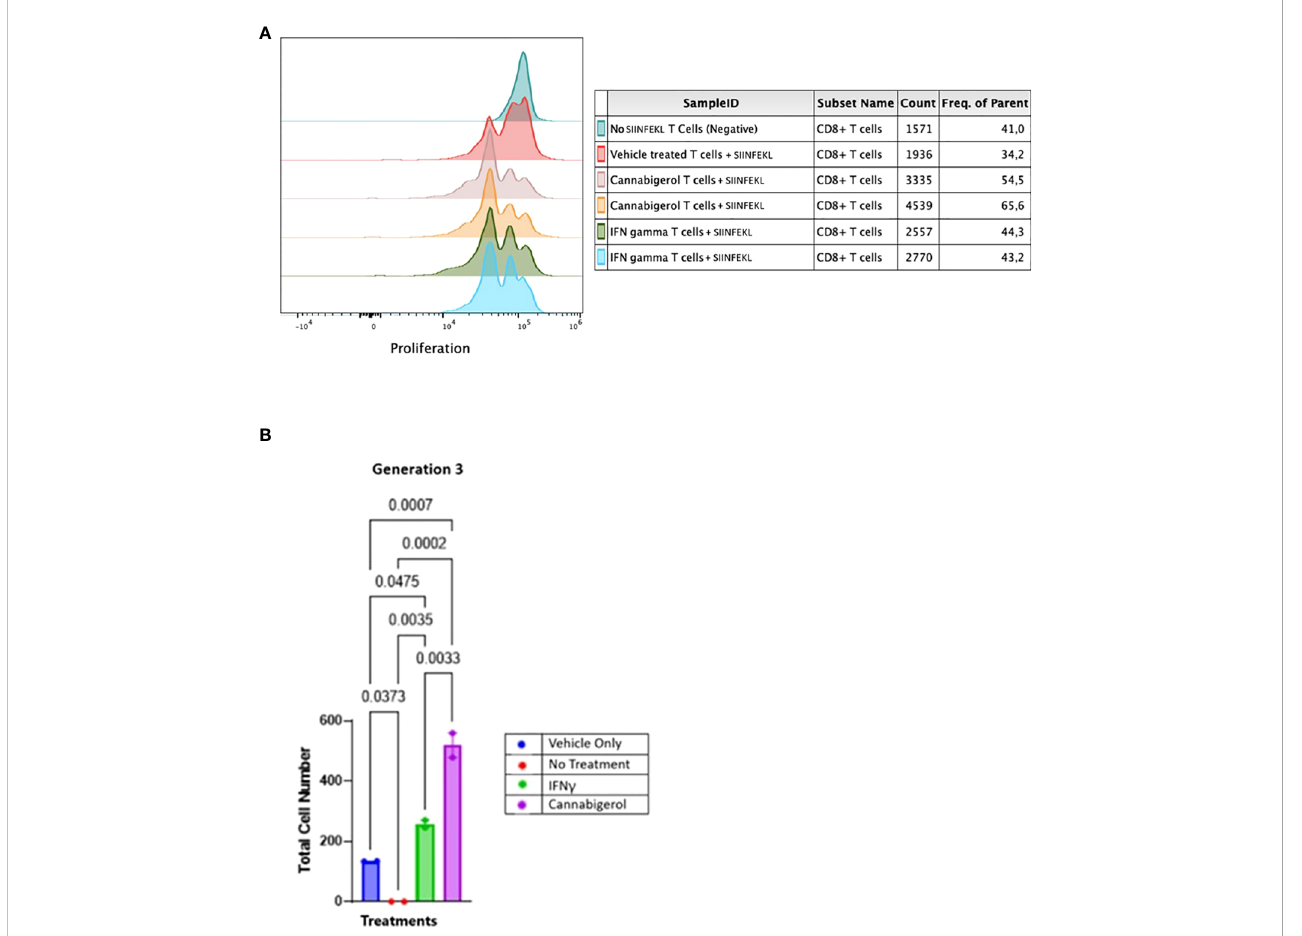
FIGURE 5 Cannabinoids treated metastatic carcinomas function as antigen presenting cells. (A) We used CD8 + T lymphocytes from SIINFEKL-primed OT1 mice that recognize and respond to SIINFEKL peptide presented on MHC class I of metastatic Murine A9 lung carcinomas. A9 cells were treated with 0.055 m mol of Cannabigerol, or 5.832x10 -6 nmol mL of IFN- g used as a positive control. The negative control is CD8 + T cells alone or untreated A9 cells pulsed with the SIINFEKL peptide from ovalbumin. T cells were labeled with CFSE proliferation dye, which is reduced within the OT1 progeny cells as the generation number increases as an indication of proliferation. (B) Statistical assessment based using the one-way ANOVA with Tukey ’ s multiple comparison test of CFSE assay demonstrates both cannabinoids and IFN- g resurrect antigen presentation in metastatic carcinomas. A P value smaller than 0.05 was considered signi fi cant. Analysis of the CFSE proliferation carried out at cellular proliferation generation 3 demonstrates that both cannabinoid and IFN-